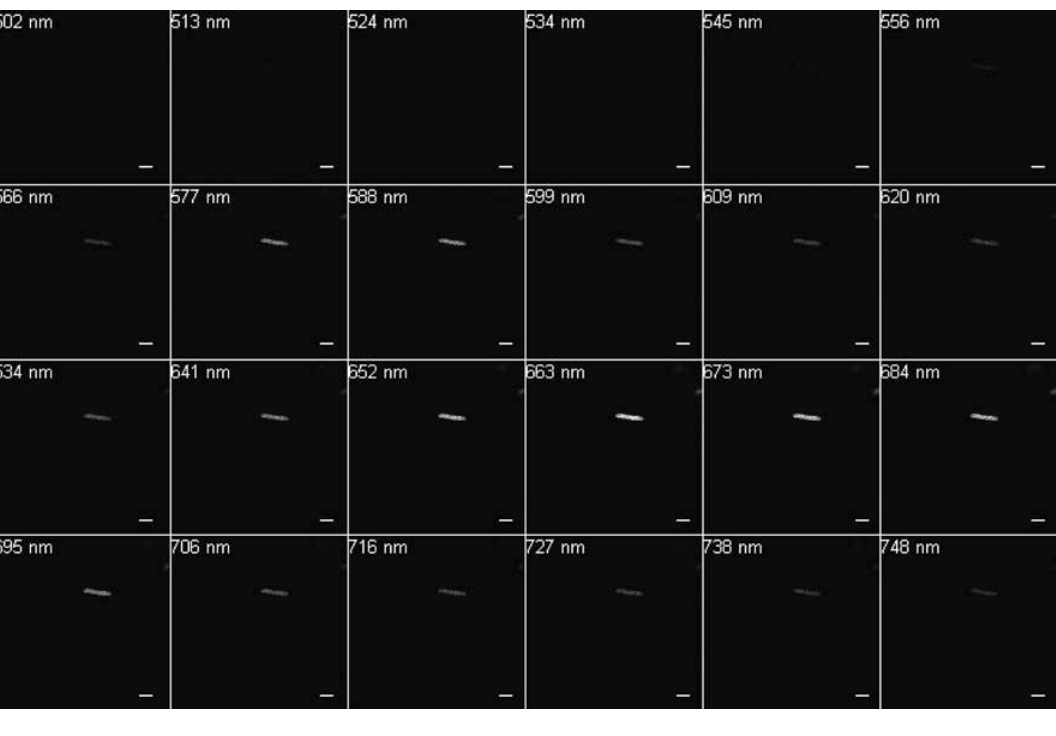
Figure 3. Spectral emission collection of SF33 GL-grown cells after excitation with 488-nm laser. An emission spectrum was gathered at 10.7-nm increments in the range from 500 nm to 750 nm. All images at 63× oil objective. Bars, 10 μm.